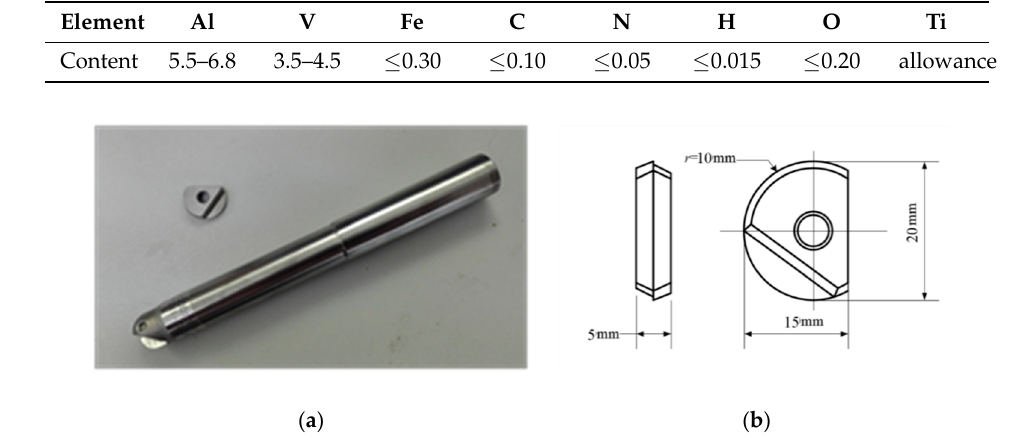
Table 2. Chemical composition of Ti6Al4V (%).